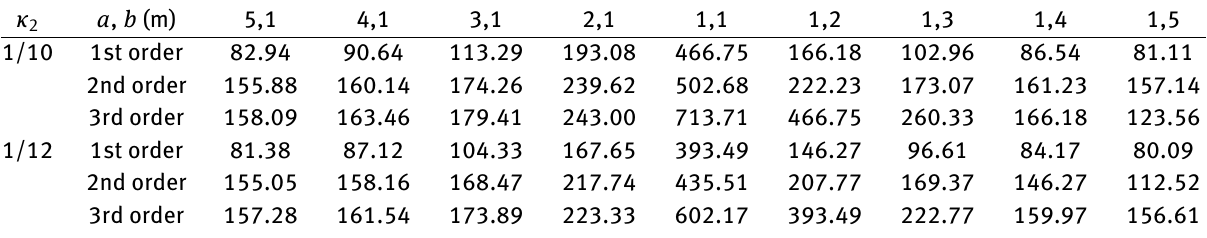
Table 6: The natural frequencies (rad/s) of analytical solutions under different length width ratios and rise span ratios κ 2